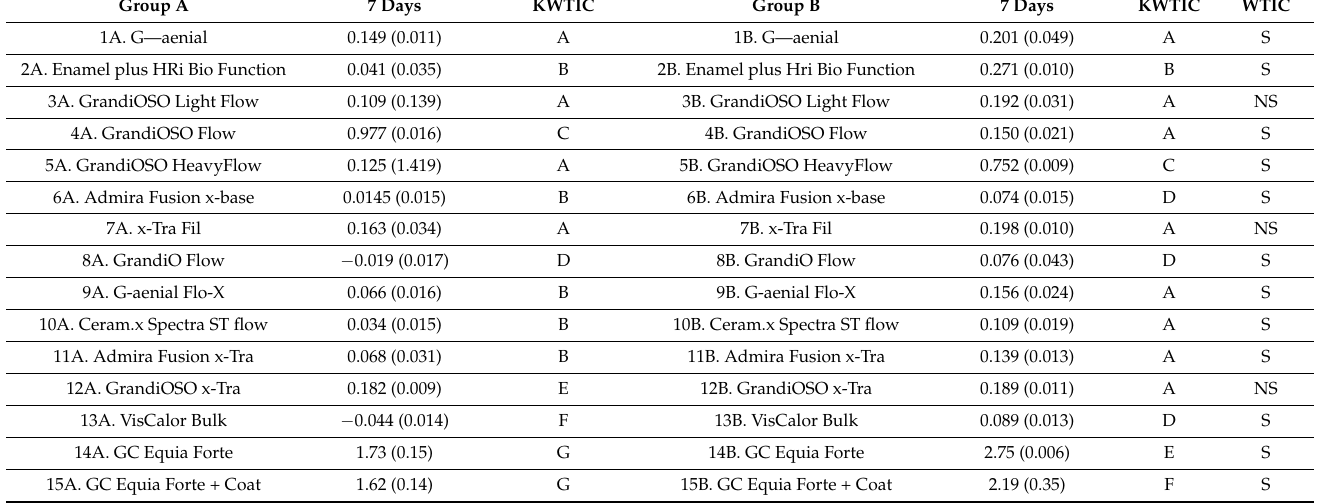
Table 2. Weight loss of materials after 7 days of acid challenge. Data are expressed as medium percentage of weight loss (SD). Different capital letters indicate statistically significant Kruskal– Wallis results for intergroup differences (KWTIC) between materials tested. Wilcoxon test results for intragroup significance (WTIC) are reported in the rows for each material, and they evaluate the differences between Group A and B for each material (S: significant; NS: not